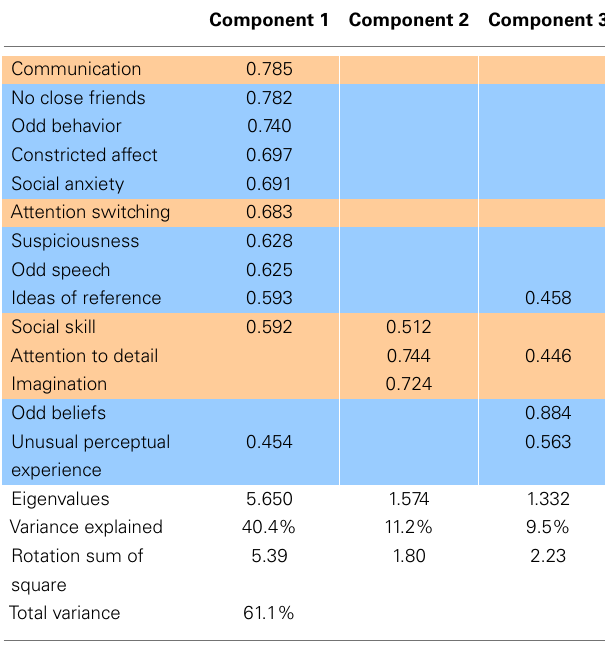
Table 3 | Principal component analysis of combinedAQ and SPQ subscales .